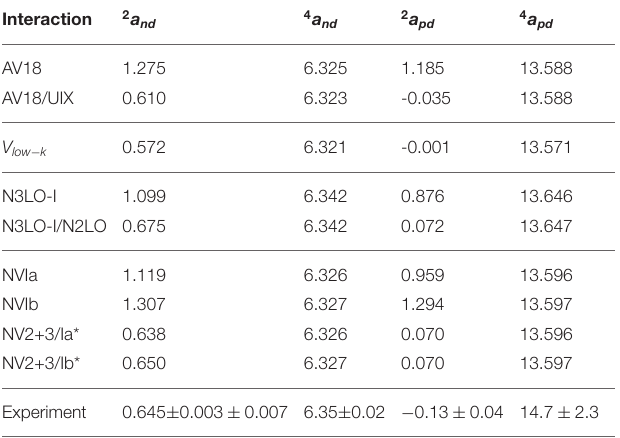
TABLE 2 | n − d and p − d doublet and quartet scattering lengths in fm calculated with the HH technique using different Hamiltonian models. Interaction